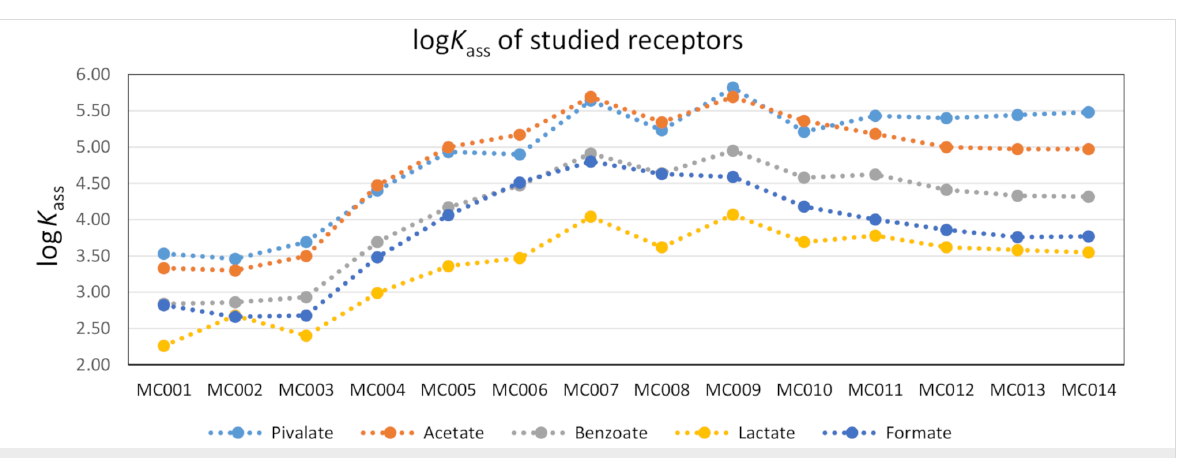
Figure 6: Binding affinities of the studied receptors towards different carboxylates in DMSO- d 6 /H 2 O (99.5%:0.5% m/m).